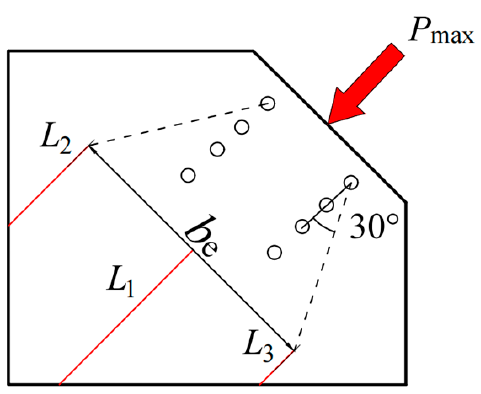
Figure 5. The analytical model of the gusset plate [27].